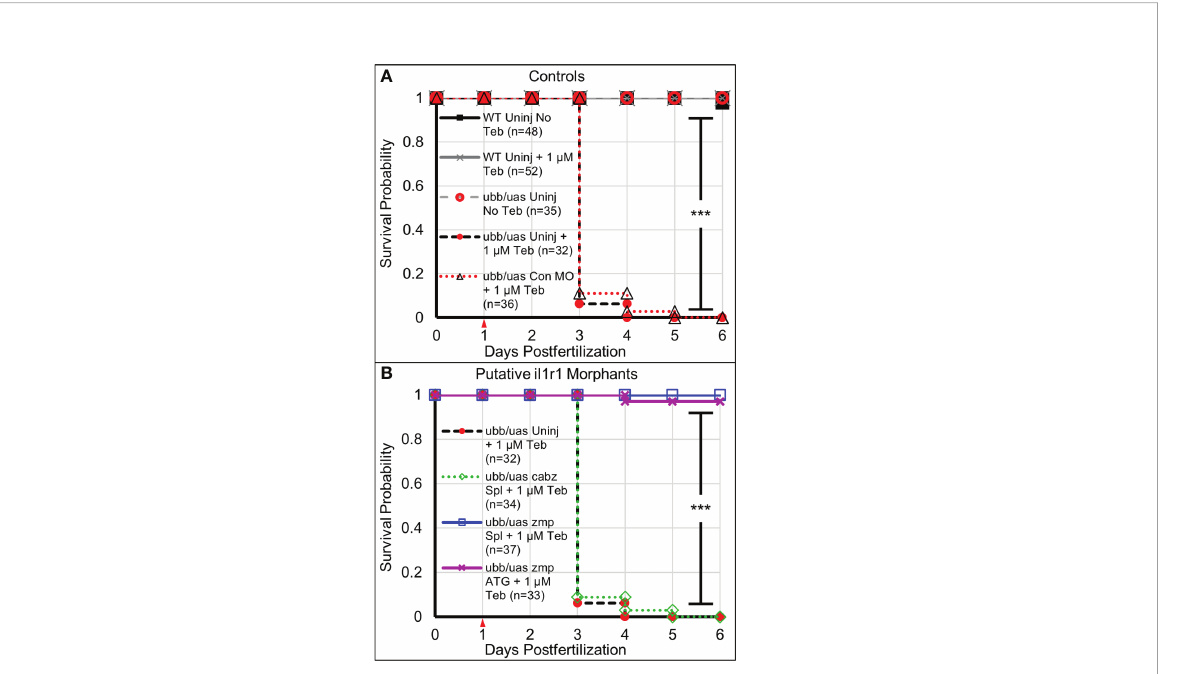
FIGURE 4 Survival analysis of Il-1 b -induced mortality. (A) Kaplan-Meier representations of the survival of WT larvae left untreated (WT Uninj No Teb), or Teb treated (WT Uninj + 1 µM Teb), ubb:Gal4-EcR , uas:Il b mat larvae with no Teb treatment (ubb/uas Uninj No Teb), with Teb (ubb/uas Uninj + 1 µM Teb), or injected with control morpholino with Teb (ubb/uas Con MO + 1 µM Teb). (B) Kaplan-Meier representations of the survival of ubb: Gal4-EcR , uas:Il b mat larvae left uninjected with teb treatment (ubb/uas Uninj + 1 µM Teb) injected with the cabz splice donor morpholino with Teb (ubb/uas cabz Spl + 1 µM Teb), zmp splice donor morpholino with Teb (ubb/uas zmp Spl + 1 µ M Teb), or zmp start site morpholino with Teb (ubb/uas zmp ATG + 1 µM Teb). Teb was added to the embryos at 1 dpf (red arrowhead). Note that only the zmp morpholinos rescued Il- 1 b -induced death.